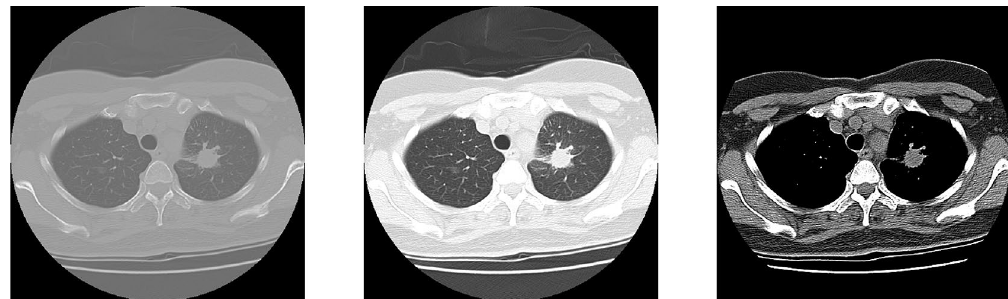
Figure 2. From left to right: Original, lungwindow and softtissue.